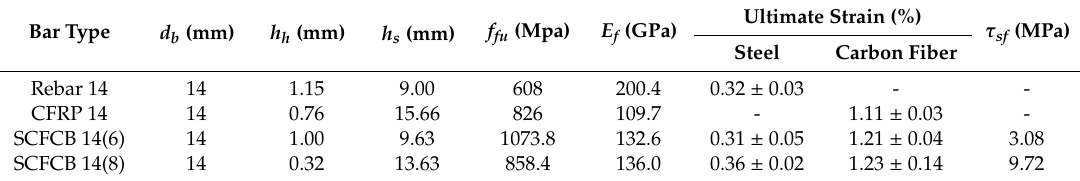
Table 1. Properties of bars.